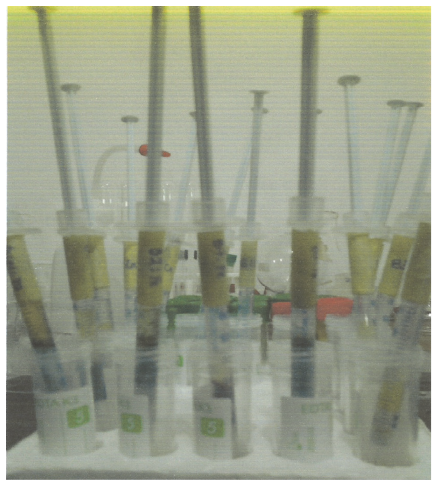
Scheme 1: The experimental setup for the column adsorption